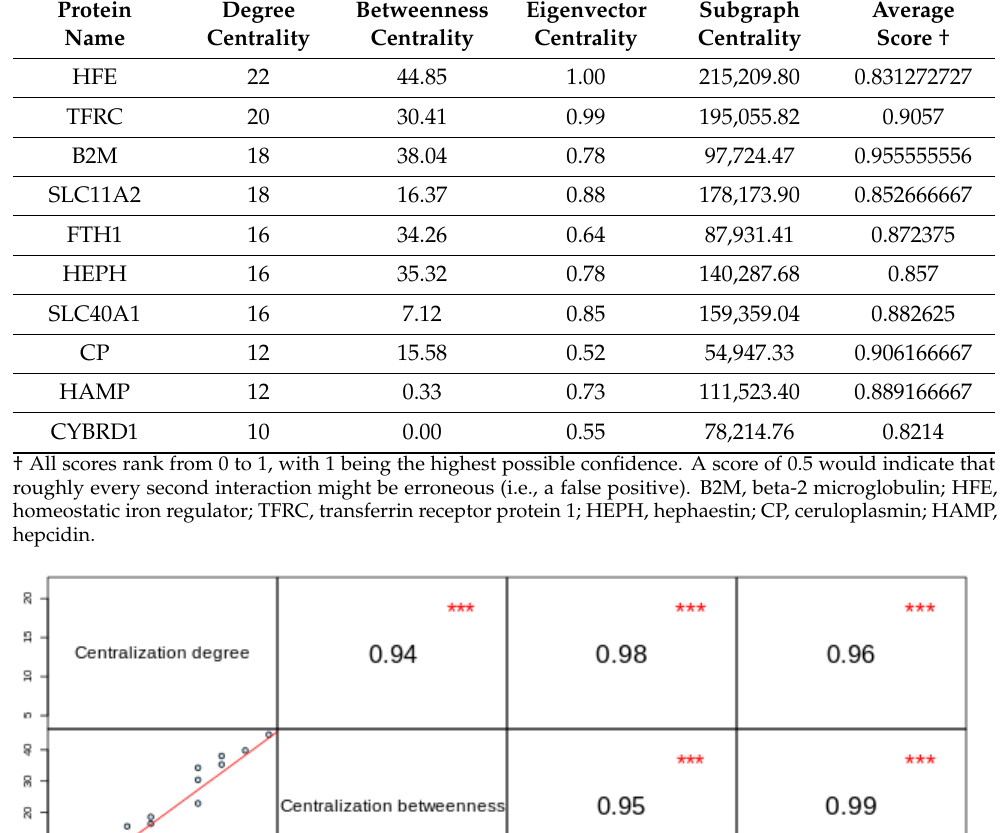
Table 3. Identification of hub-proteins based on network topology.